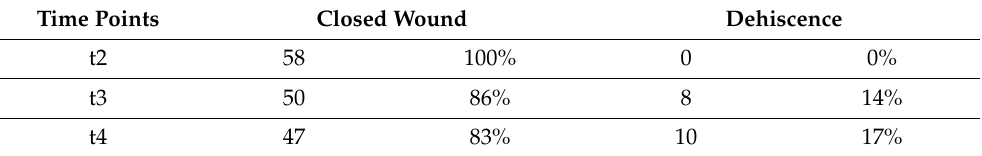
Table 5. Intraoral mucosal status at different points in time (absolute numbers and